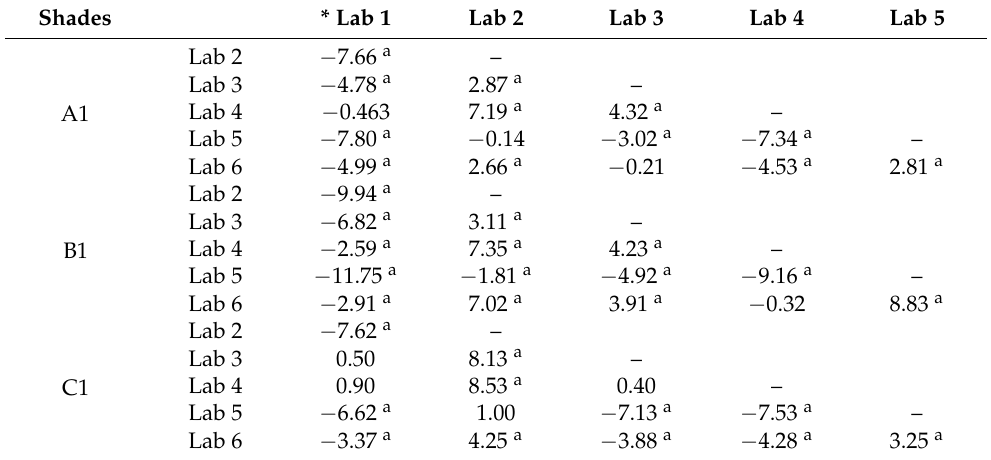
Table 4. Mean differences between the delta E of the tested laboratories by post hoc Tukey HSD tests.